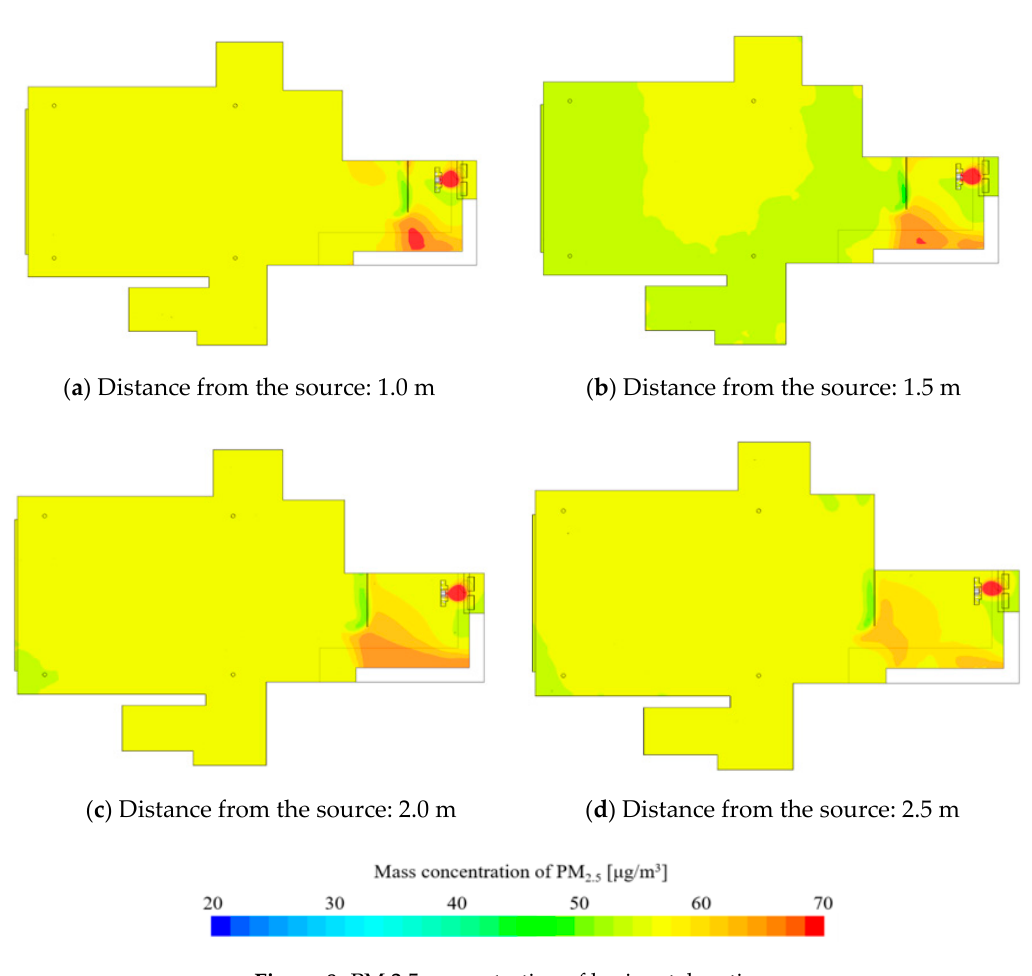
Figure 8. PM 2.5 concentration of horizontal section.